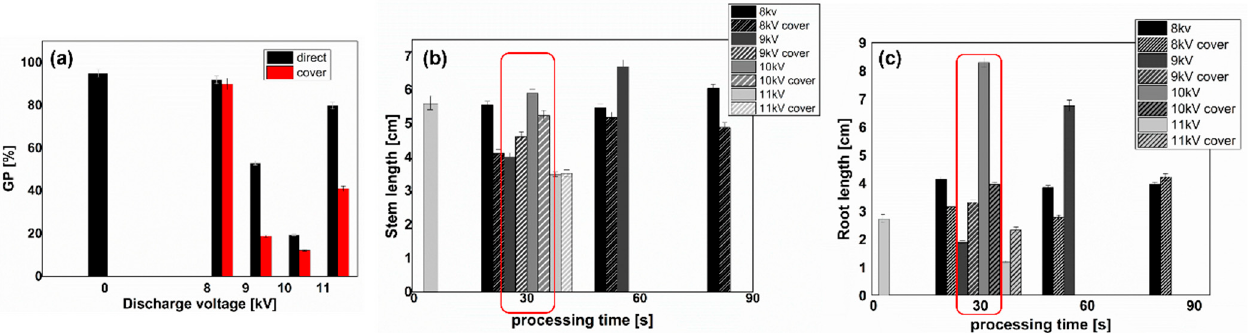
Figure 4. ( a ) Germination potential for broccoli seeds for 30 s treatments with and without cover: ( b ) stem length and ( c ) root length for broccoli seeds ( p < 0.005). With cover, the germination potential of broccoli seeds is smaller in all voltage cases, as can be seen from Figure 4 (a), similar to our previous work [39]. For processing periods of 60 s and longer, the germination process is inhibited, especially for voltages higher than 10 kV, which corresponds to an approximate power density of about 0.03 W/cm 3 . Still, small but significant increase of the stem length of the sprouts was noticed for the 9 kV, 60 s treatment and 10 kV, 30 s conditions. For short exposure intervals, there is no linear correspondence between stem length or root length and voltage or discharge power (Fig- ure 4 (b) and (c)). With cover, the inhibition effects are much stronger than for direct treat- ment without cover, indicating a strong contribution of the reactive species. To explain this phenomenon, we analyzed the surface of the seeds using ESEM. The images in Figure 5 can be correlated with the above-mentioned results; Figure 5f indicates drastic changes in the surface morphology under 14 kV with cover treatment of the seeds. In these treatment conditions, we also saw a decrease of the water contact angle. Overall, using high discharge voltages and the concentrated action of reactive species, the surface of the broccoli seeds is first cleaned; then, the etching process reaches the inside layers, decreasing the water contact angle, facilitating the diffusion of reactive species towards the inside of the seed, and stimulating the growth of sprouts, or for intense treatments (longer and high voltage NTP), rupturing of the cell walls on the epidermis with exposure of inner layers is evident (Figure 5f). The changes are more obvious for broccoli than for cress. Similar disintegration of the outer layer of the seeds and irregular shape agglomer- ations (as seen in Figure 5) have been also reported in DBD-treated quinoa seeds [51], low pressure treatment processing of Arabidopsis thaliana [52], and wheat treatment [53]. With cover, the broccoli seed surface outer cell layer is removed (Figure 5e), while for cress, although a change is not obvious (Figure 5g–i), the evaluation of roughness, as per- formed using imageJ, indicates only slight modification for simple sDBD treatment (83.01 ± 1.30) compared to untreated samples (88.77 ± 1.30), and stronger modification for the concentrated reactive species treatment (Figure 5i) (113.70 ± 1.30).